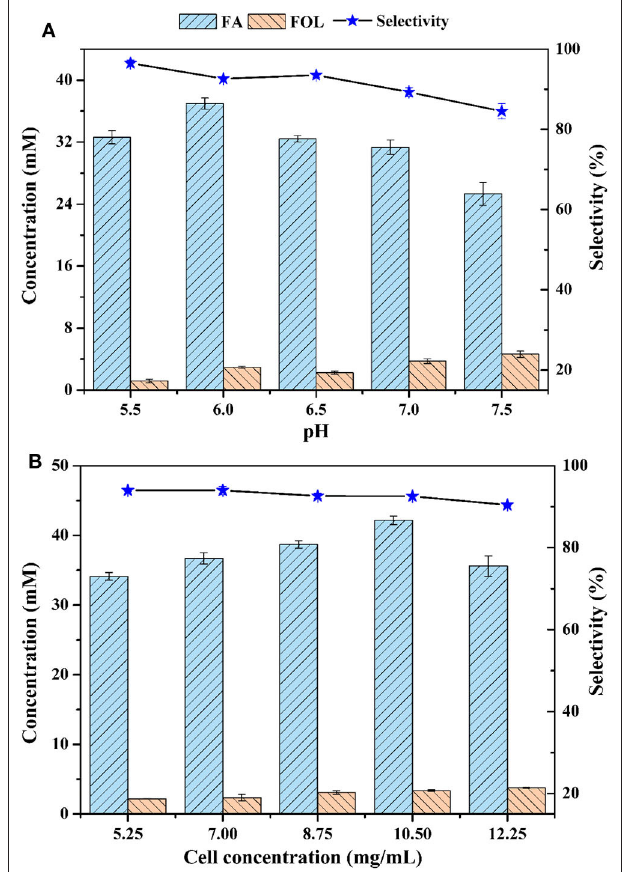
FIGURE 2 | Effect of pH (A) and cell concentration (B) on biocatalytic oxidation of FAL. Reaction conditions: phosphate buffer (200mM) with designated pH for (A) and pH 6.0 for (B) , 70mM FAL, 7 g/L cells (dry weight) for (A) and designated cell concentrations (dry weight) for (B) . Other parameters were same as Figure 1